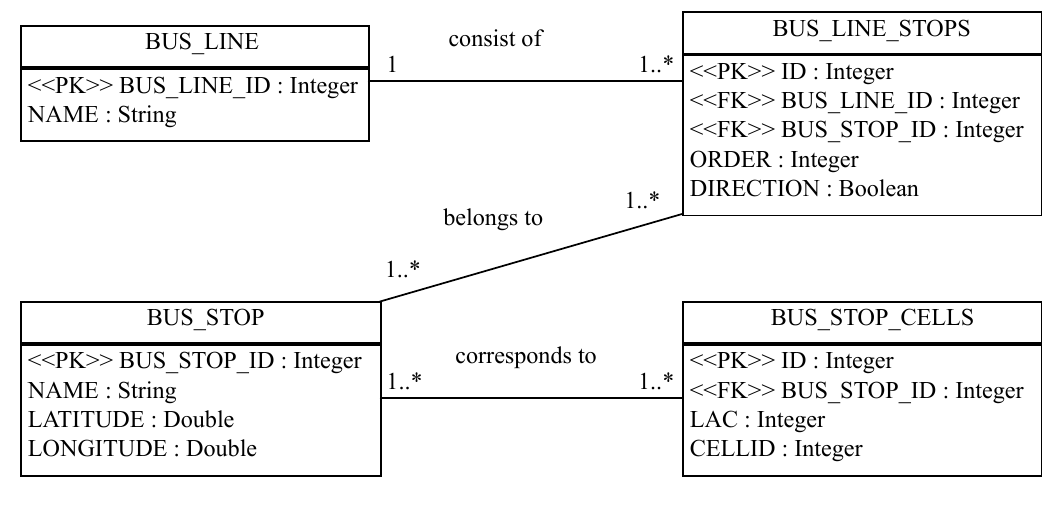
Figure 12. Data model corresponding to the database with the bus lines and corresponding cell identifiers